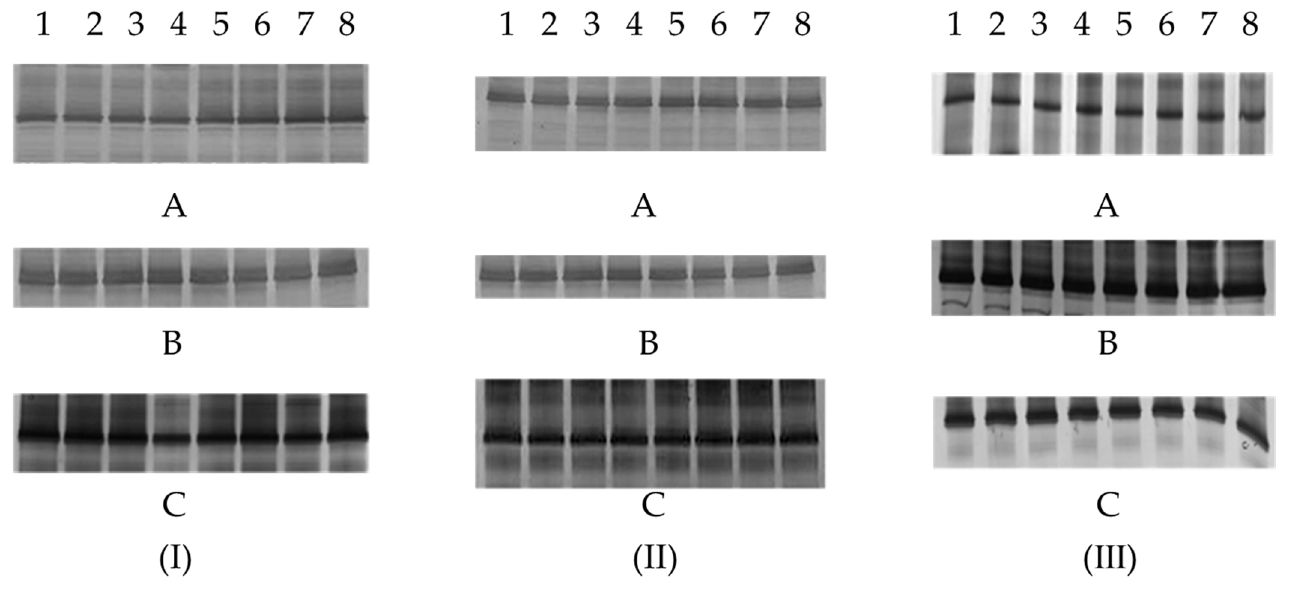
Figure 3. The DGGE analysis of variations of three dominant YLS Ascomycetes symbionts ( I ), Pichia - like symbionts ( II ), Candida -like symbionts ( III ) of BPH rearing on three different resistant rice varieties Mudgo ( A ), ASD7 ( B ), and RH ( C ), respectively. Numbers 1–8 represent the 1st generation to the 8th generation of BPH female